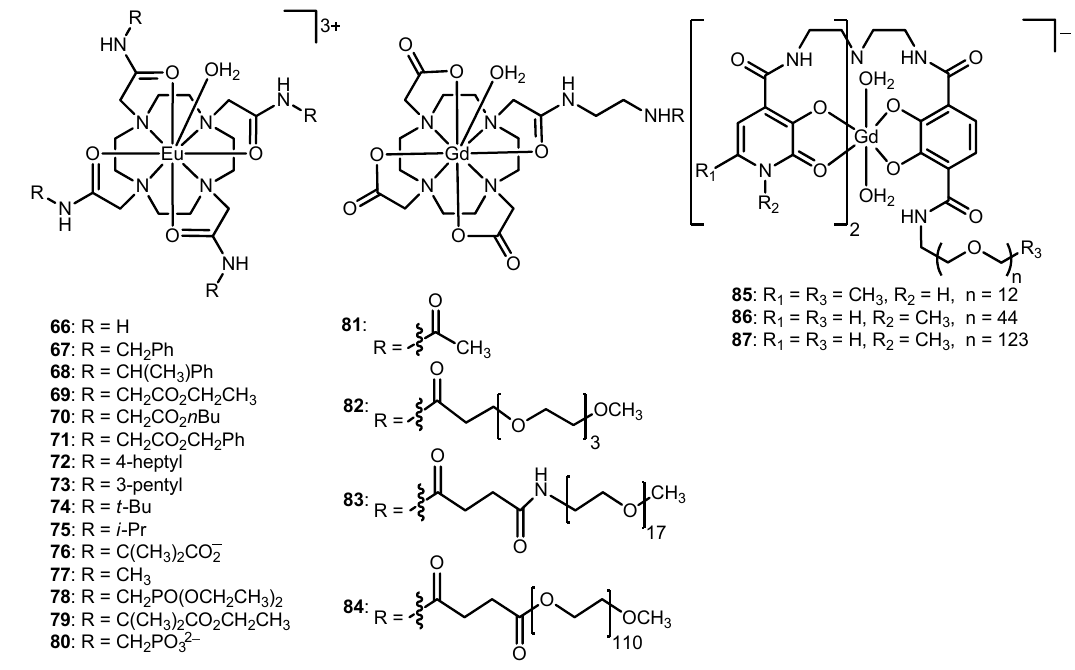
Figure 7. Representative complexes 66 – 87 that relate the influence of bulkiness and polarity of ligand side chains and water-exchange rates [15,27,63–69].